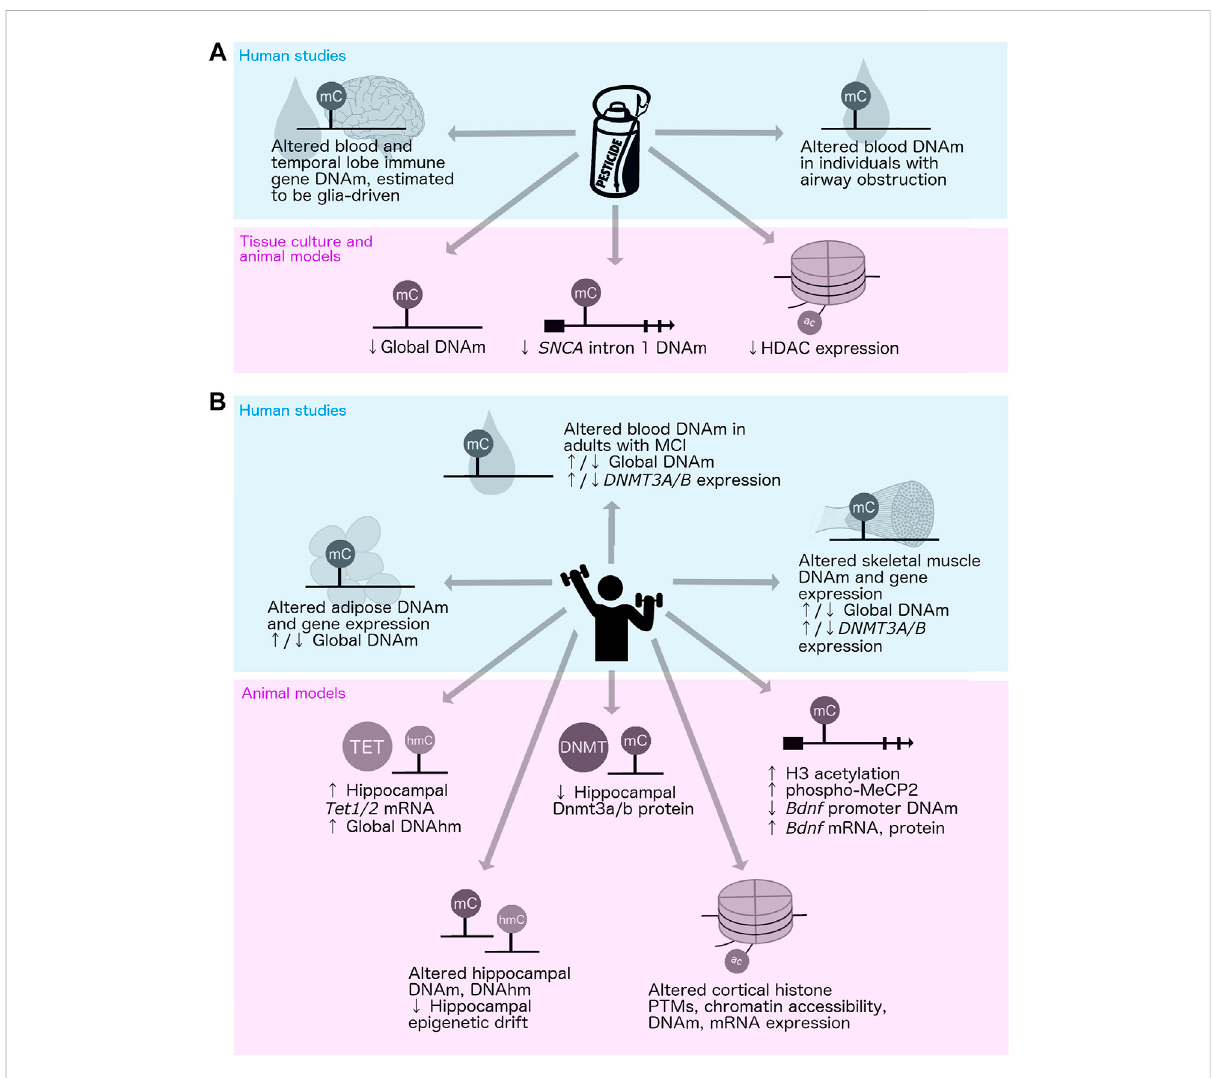
FIGURE 4 Impacts ofpesticide exposureandphysicalactivityontheepigenome.Upanddownarrows( ↑ / ↓ )indicatecon fl ictingresults;i.e.,bothincreases and decreases reported across different studies of the same mechanism. (A) Human (top: van der Plaat et al., 2018; Go et al., 2020; Furlong et al., 2020) and tissue culture/animal (bottom: Park et al., 2016; Wnuk et al., 2016; Zhao et al., 2019) studies of pesticide exposure and epigenetic alterations. (B) Human(top:Rönnetal.,2013;Lindholmetal.,2014; Ś wiatowyetal.,2021;Ngwaetal.,2022)andanimal(bottom:Gomez-Pinilla et al., 2011; Elsner et al., 2013; Irier et al., 2014; Jessop and Toledo-Rodriguez, 2018; Wassouf et al., 2018; Zhang et al., 2018; Zocher et al.,